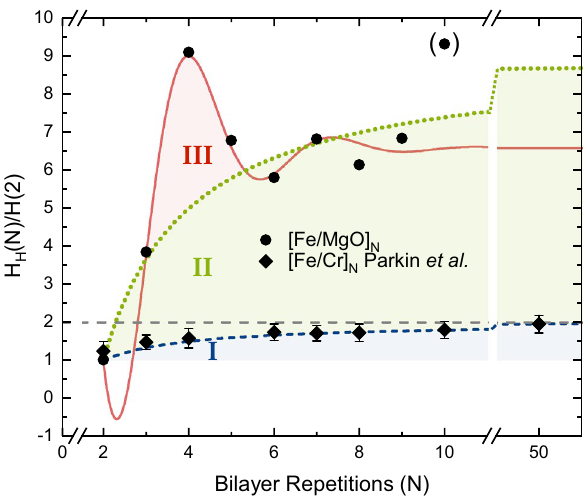
Figure 4. Normalized saturation field, [ H H ( N )/ H ( 2 ) ], of [Fe/Cr] N and [Fe/MgO] N (001) samples with different number of bilayer repetitions ( N ). H (2) is the switching field of a sample with two Fe layers and H H ( N ) is the saturation field of a sample with N bilayer repetitions. The dashed, blue line is the fit of the data obtained from Ref. 18 . The dotted, green and solid, red lines are fits of the Fe/MgO(001)